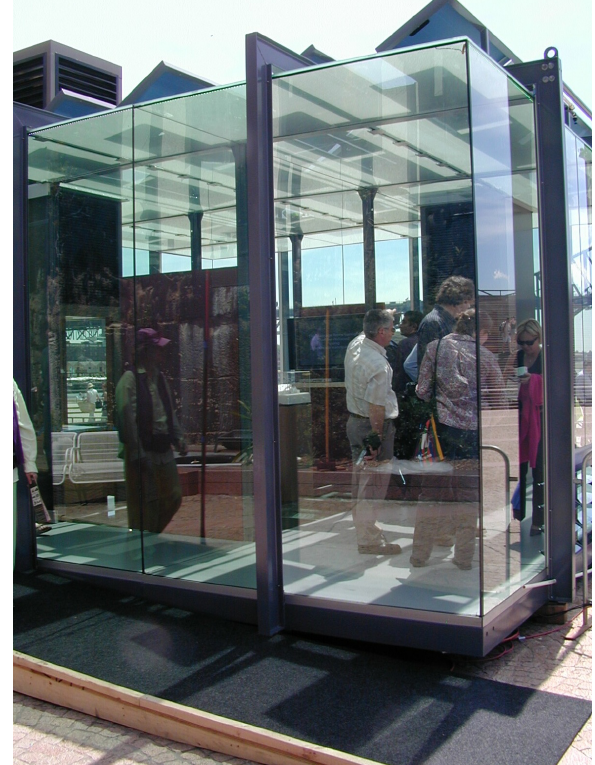
Fig. 4. The ‘NanoHouse’, a glass structure designed to demonstrate the best of radiative and convective heat transfer control in a struc- ture exposed to subtropical sunlight (photo, MB Cortie).